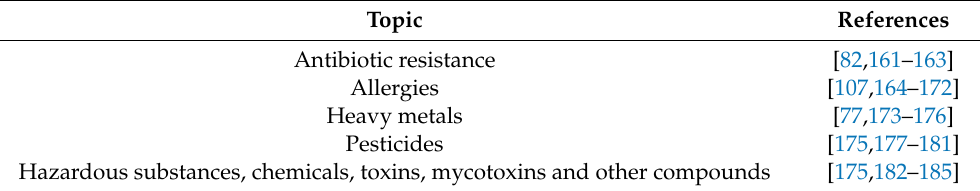
Table 6. Research studies investigating various aspects of mealworm